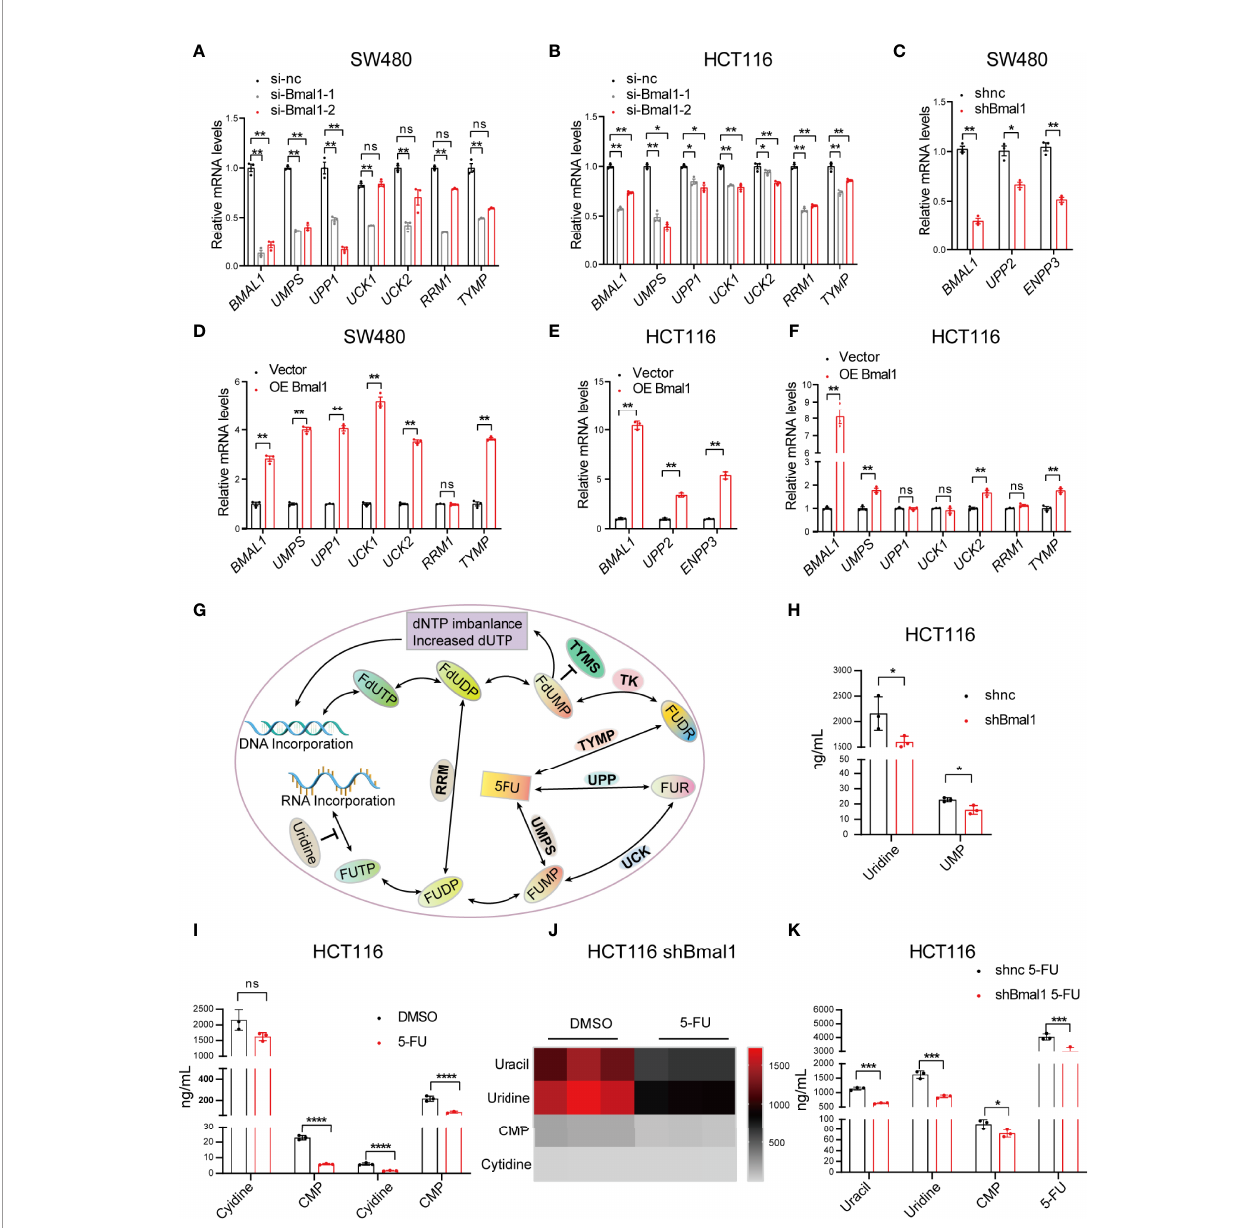
FIGURE 4 | BMAL1 extensively regulates gene expression in the pyrimidine metabolic pathway and stimulates pyrimidine metabolism in CRC cells. (A – C) Con fi rmation of the changes in pyrimidine pathway genes related to 5-FU metabolism, while BMAL1 was deregulated in SW480 and HCT116 cells by qPCR. (D – F) Con fi rmation of the changes in pyrimidine pathway genes related to 5-FU metabolism, while BMAL1 expression was upregulated in SW480 and HCT116 cells, as shown by qPCR. * indicates p < 0.05, ** indicates p < 0.01 versus si-nc or vector, ns indicates there is no signi fi cance. (G) Schematic depicting the mechanism of 5-FU. In brief, 5-FU is converted into various fl uoronucleotide derivatives that disrupt RNA and DNA syntheses by incorporation into RNA and DNA, thus exerting its cytotoxic effects in cells. The mechanism of 5-FU activation is conversion to fl uorouridine monophosphate (FUMP), either directly through orotate phosphoribosyltransferase (UMPS) or indirectly by fl uorouridine (FUR) through the sequential action of uridine phosphorylase (UPP) and uridine kinase (UK). Other enzymes depicted are thymidine phosphorylase (TYMP), thymidine kinase (TK), thymidylate synthase (TYMS) and ribonucleotide reductase (RRM). Other metabolites indicated are fl uorodeoxyuridine (FUDR), fl uorodeoxyuridine monophosphate (FdUMP), fl uorouridine diphosphate (FUDP), fl uorodeoxyuridine diphosphate (FdUDP), fl uorouridine triphosphate (FUTP), fl uorodeoxyuridine triphosphate (FdUTP), deoxynucleotide (dNTP), and deoxyuridine triphosphate (dUTP). (H) The content of pyrimidine metabolites in shBmal1 and shnc cells measured by LC-MS. (I) The content of pyrimidine metabolites in shnc cells after 5-FU treatment (500 m M). (J) Heatmap showing the contents of uracil, uridine, cytidine monophosphate (CMP), and cytidine in shBmal1 cells after 5-FU treatment (500 m M). (K) Detection of the contents of uracil, uridine, CMP, and cytidine in shBmal1 cells after 5-FU treatment using LC-MS (n = 3, unpaired t test). * indicates p < 0.05, *** indicates p < 0.005, **** indicates p <